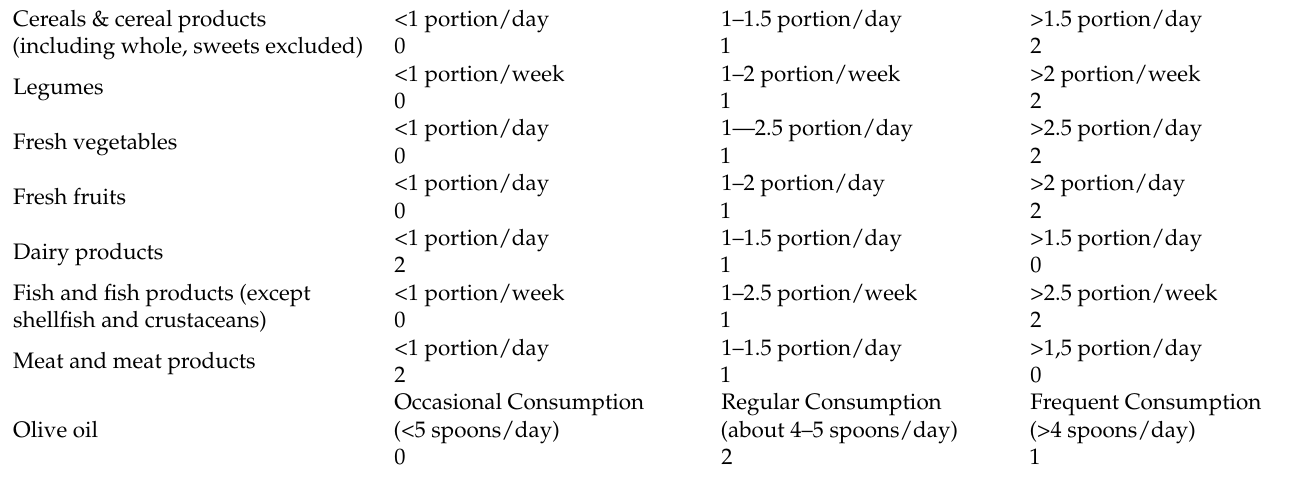
Table 2. Mediterranean diet score.